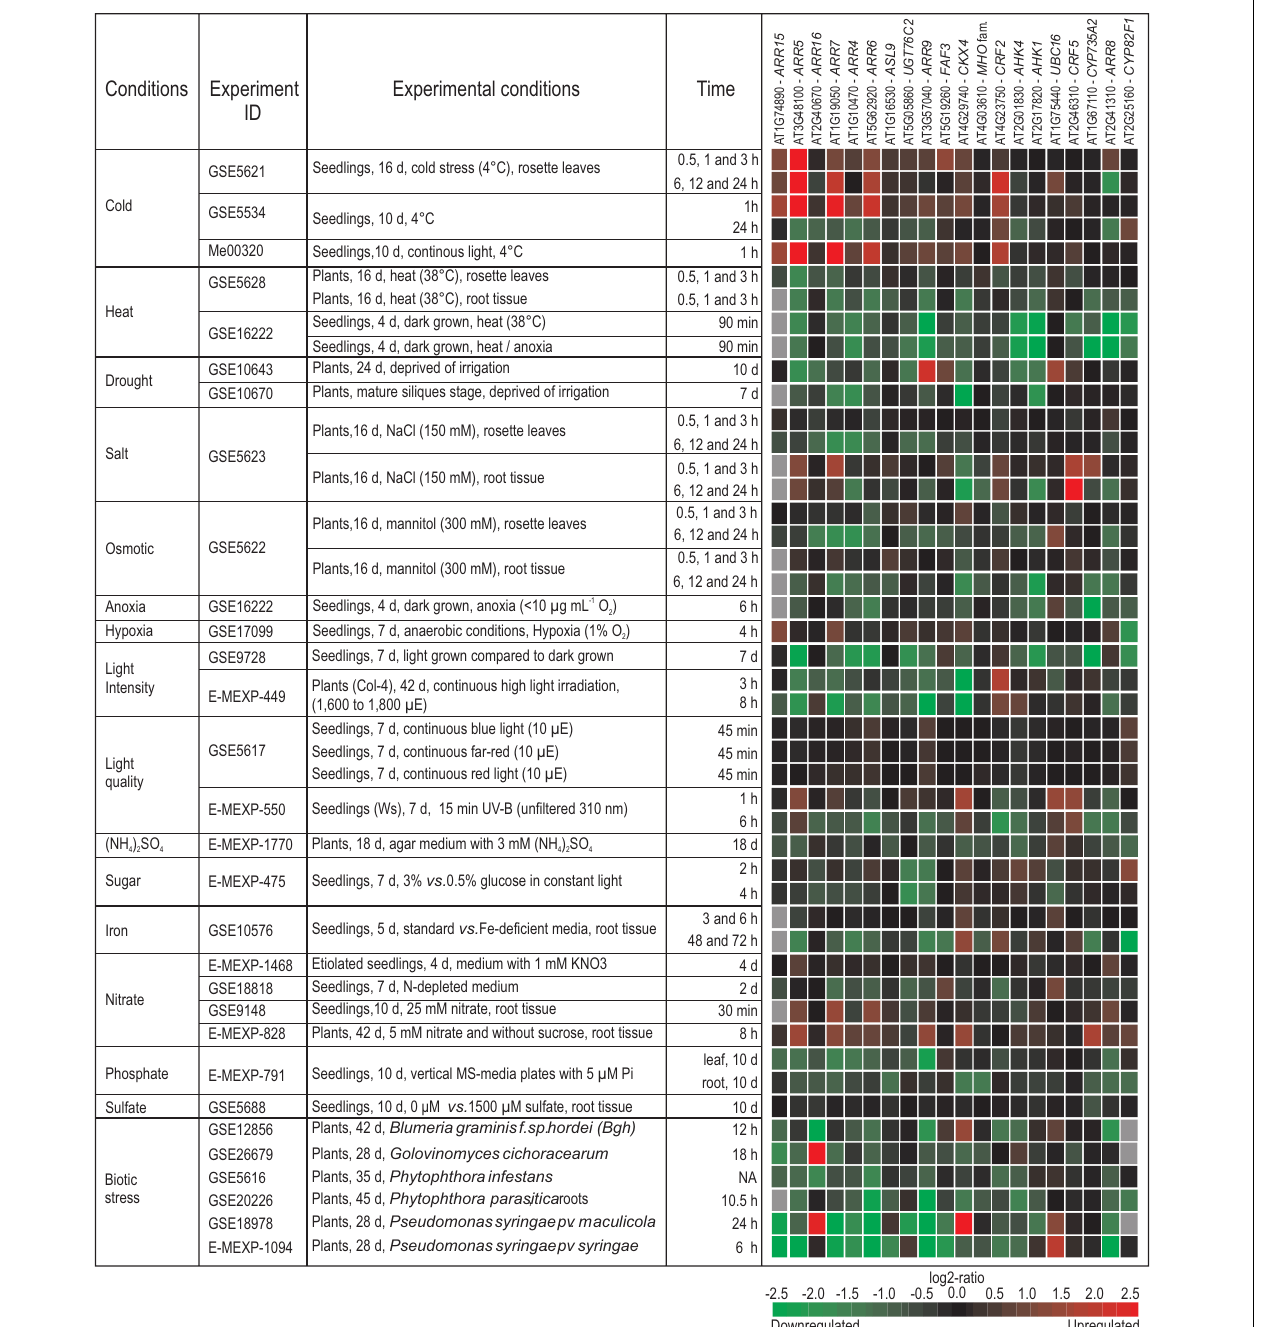
FIGURE 4 | Regulation of cytokinin response genes by different environmental cues. The meta-profile analysis for the changes in transcript abundance of the top 20 cytokinin response genes ( Table 2 ) in response to different stresses or environmental cues was established with the Genevestigator database (http://www.genevestigator.com/gv/index.jsp; Hruz et al., 2008) and modified.The figure shows an arbitrary selection of experiments which was selected based on one of the following criteria: (i) Stress (abiotic and biotic) treatment of wild-type plants; (ii) nutrient changes deprivation) and other treatments of wild-type plants; and (iii) only experiments using Col-0 were considered unless otherwise specified. If data for several time points after the treatments were available, data showing early